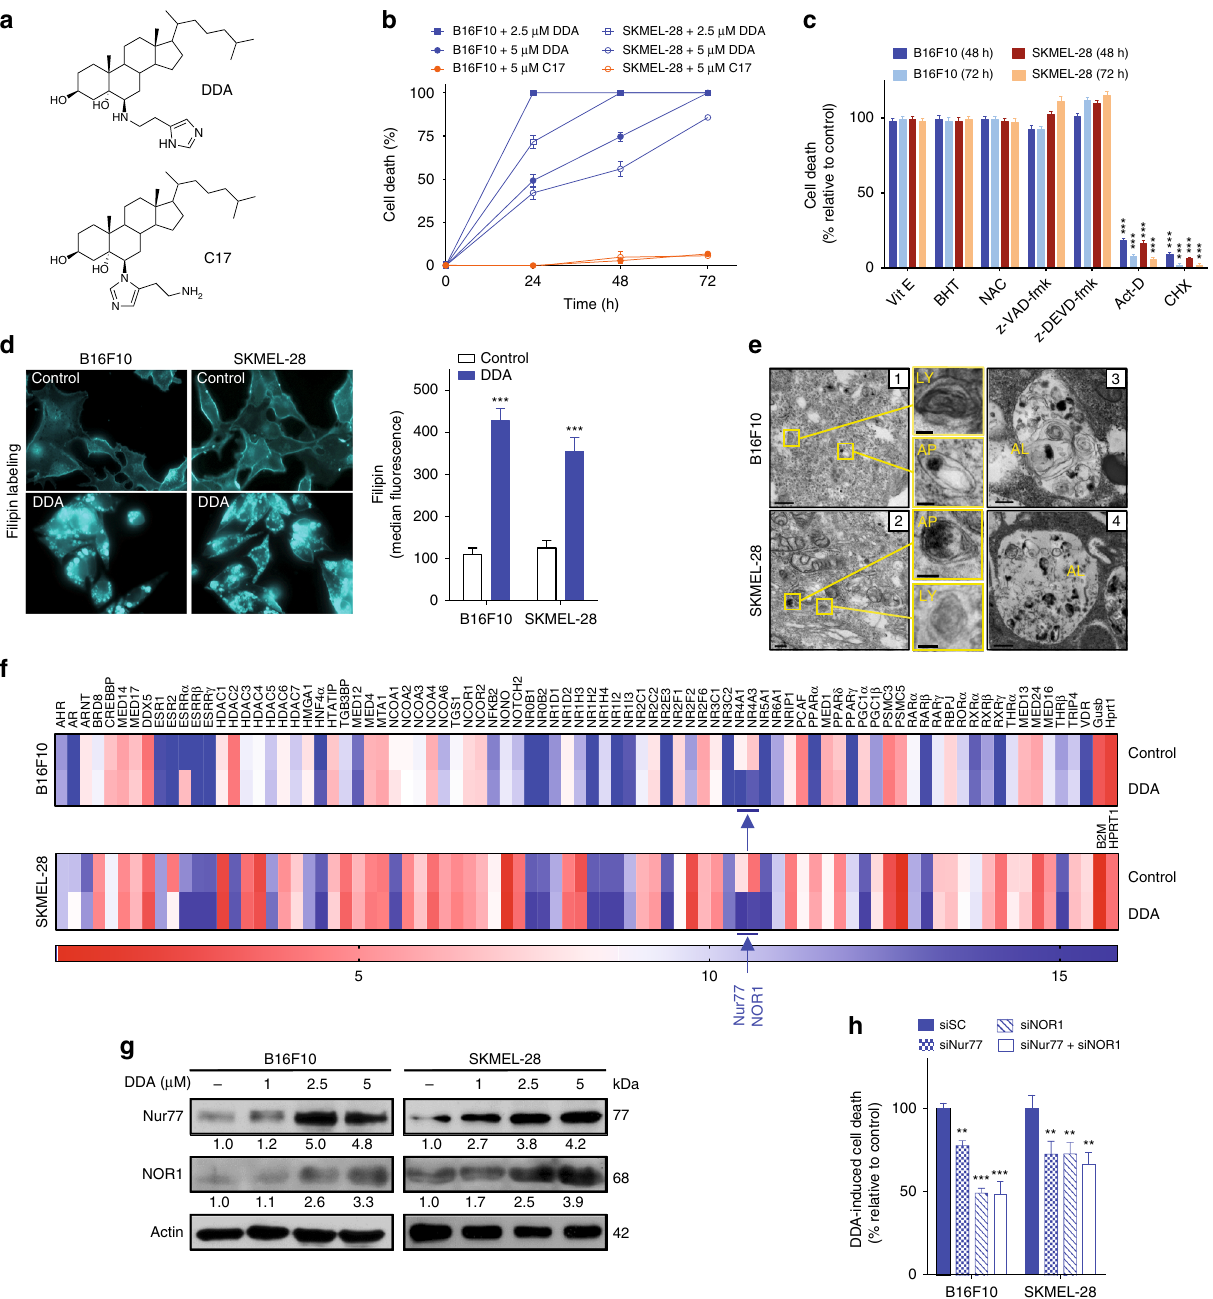
Fig. 1 Nur77 and NOR1 are required for the induction of cell death by DDA in melanoma. a Chemical structure of DDA and C17. b B16F10 and SKMEL-28 cells were treated or not for 24, 48, or 72 h with DDA or C17. DDA- or C17-induced cell death was determined by a trypan blue assay and expressed as the percentage cell death relative to control (vehicle). c Cells were treated with 5 µ M DDA for 48 h or 72 h with or without 500 µ M vitamin E (Vit E), 50 µ M z- VAD-fmk, 50 µ M z-DEVD-fmk, 1 µ g/ml actinomycin D (Act D) or 2.5 µ g/ml cycloheximide (CHX), and cell death was measured as in b . d DDA induced the accumulation of free sterols in cells. Cells were treated with solvent vehicle or 2.5 µ M DDA for 48 h, then fi xed and stained with fi lipin and analyzed by fl uorescence microscopy. e Representative EM images of B16F10 (panels 1 – 3) and SKMEL-28 (panels 2 – 4) cells treated for 24 h with 2.5 µ M DDA. Ly: multilamellar body-derived lysosomes, AP: autophagosomes, AL: autolysosomes, N: nucleus, C: cytoplasm. Bars: 250 nm for panel 1 and 100 nm for inserts; 500 nm for panel 2 and 100 nm for inserts; 500 nm for panel 3; and 250 nm for panel 4. f Heat map depicting transcription of genes encoding nuclear receptors (NR) and their co-regulators, using PCR arrays in B16F10 and SKMEL-28 cells treated or not with 2.5 µ M DDA for 5 h, using PCR arrays. g Immunoblot for Nur77 and NOR1 protein expression in melanoma cells treated or not with DDA for 24h. h Analysis of DDA cytotoxicity in B16F10 and SKMEL-28 cells transfected with control scramble siRNA (siSC), siNur77 and/or siNOR1. 72 h after transfection, cells were treated or not for 24 h with 2.5 µ M DDA. Cell death is expressed as a percentage relative to the level of cell death induced by DDA in cells transfected with a scramble control siRNA (siSC). Data from b – d and h are the means ± S.E.M. of three independent experiments performed in triplicate, ** P < 0.01, *** P < 0.001, t -test. All images and densitometry values are representative of three independent